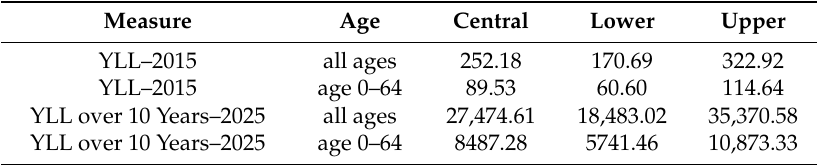
Table 4. Years of Life Lost (YLL) due to premature mortality. Measure Age Central Lower Upper YLL–2015 all ages 252.18 170.69 322.92 all